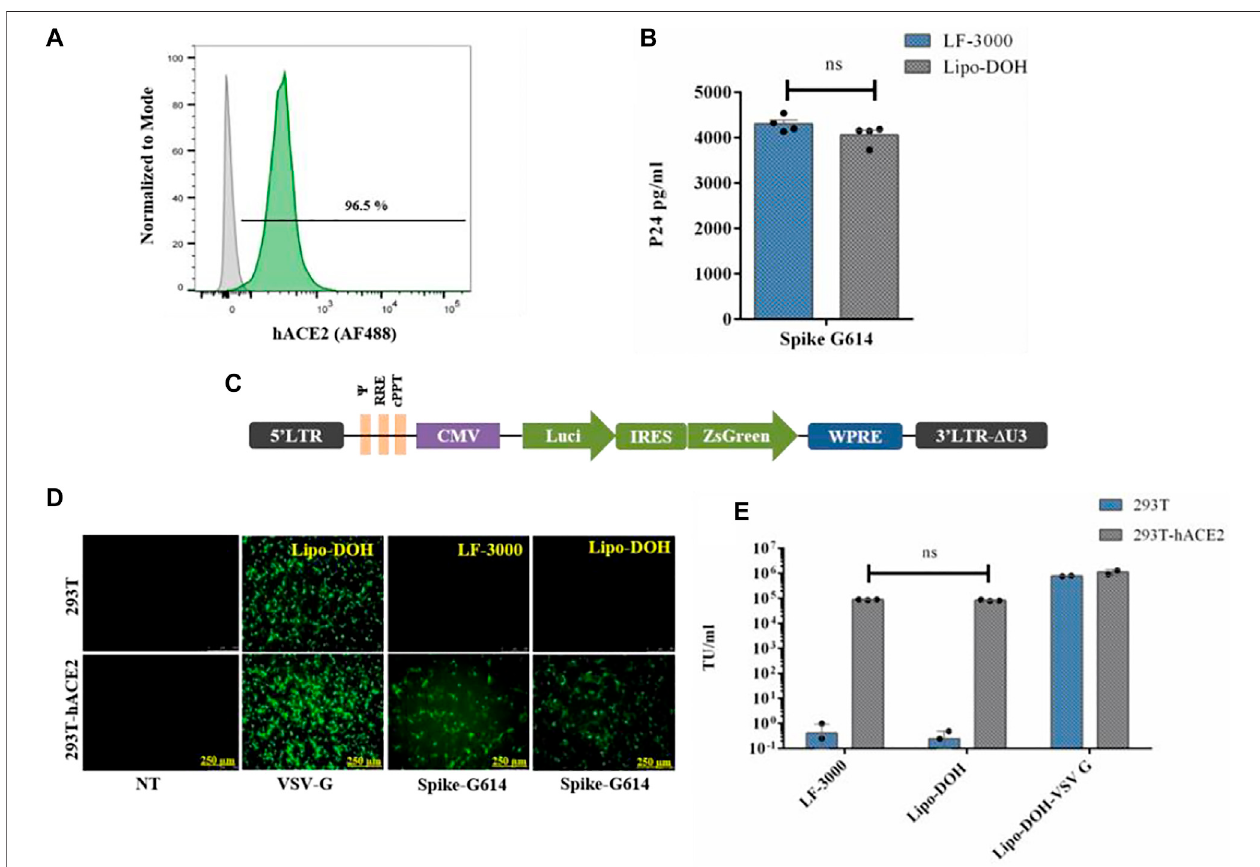
FIGURE3| ComparativestudyofspikeG614pseudovirusproductionandfunctionalef fi ciencybyLF-3000andLipo-DOHliposomedeliverysystem.Expressionof hACE2 protein in 293T-hACE2 stable cell line was con fi rmed by immunostaining followed by fl ow cytometry (A) . Pseudovirus produced in HEK-293T cells by LF-3000 and Lipo-DOH and the quanti fi ed level of pseudovirus by p24 ELISA (B) . The vector map of Lenti transfer plasmid which is used in this study (C) . The functional titer of pseudovirus was performed into 293T and 293T-hACE2 cells at different dilution of viral supernatants. At 72-h post transduction, pseudoviruses infectivity was imagedusinga fl uorescentmicroscope(imageshowsinfectivityofVSV-Gpseudovirusat1/10 th dilutionandspike-G614at1/2nddilution) (D) ,andtransductionunitwas calculated from ZsGreen positive cells that were quanti fi ed by fl ow cytometry. (E) ns, non-signi fi cant between groups. Data mean ± SEM.